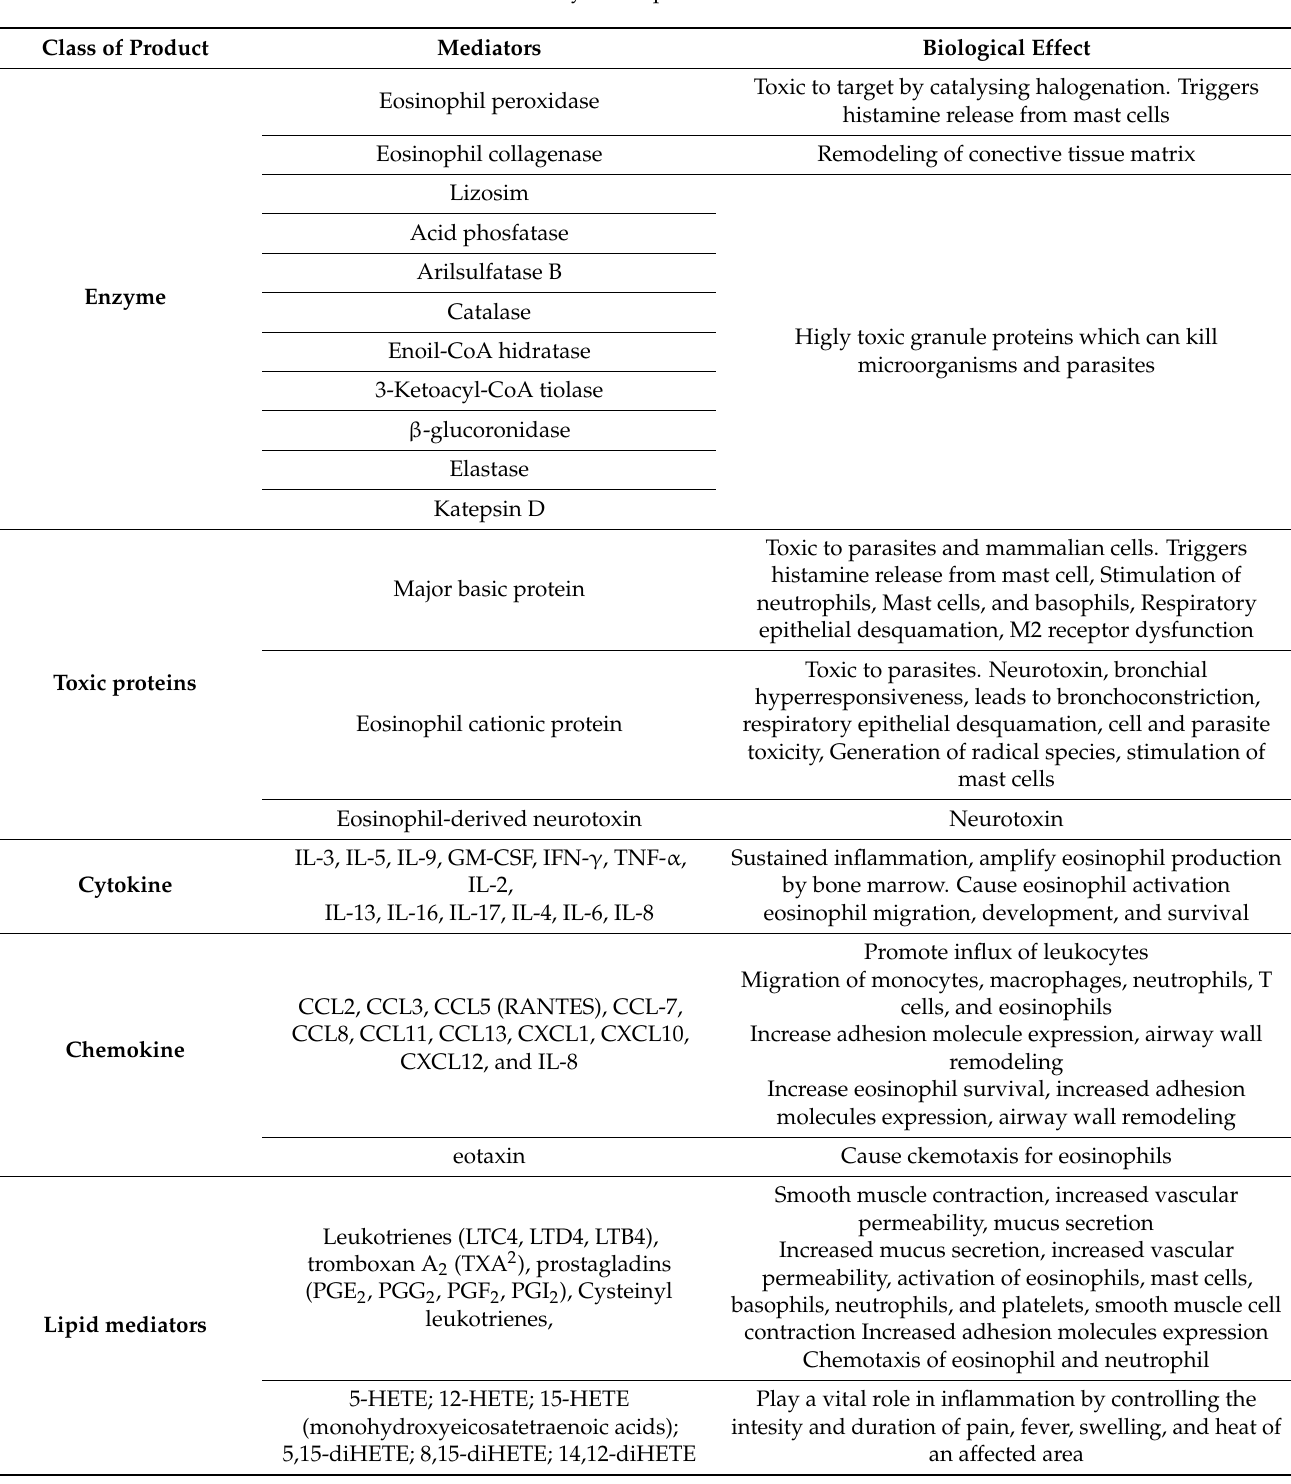
Table 4. Eosinophils secrete a range of highly toxic granule proteins and other mediators of inflam- mation that are released by